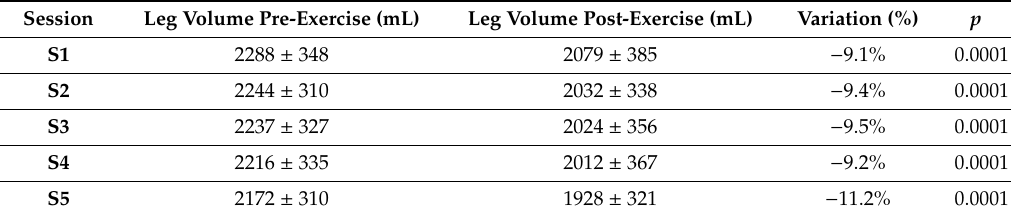
Table 3. Leg volume variation pre- and post-exercise of every single